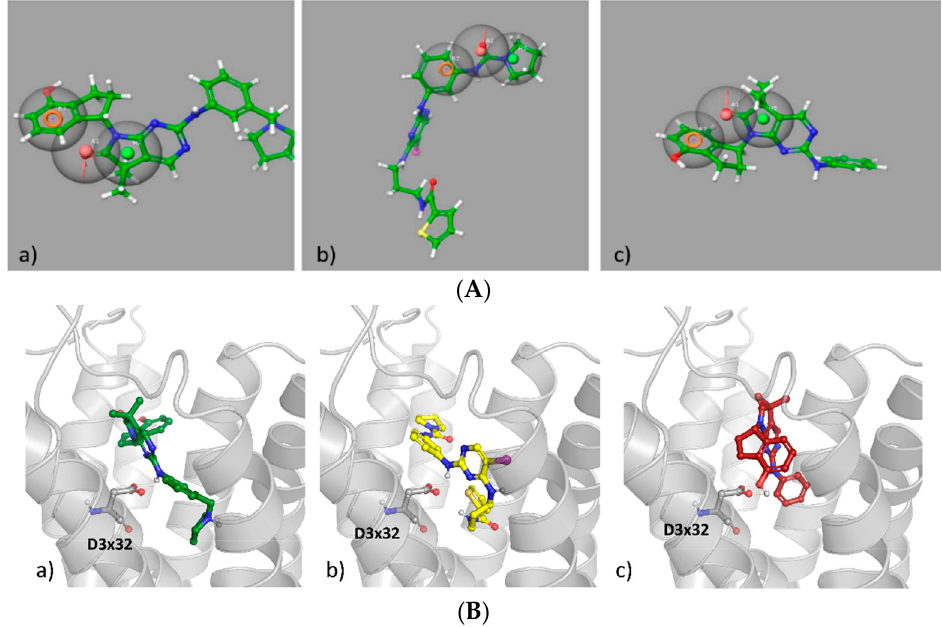
Figure 9. Examples of the most active MARK4 inhibitors: ( A ) mapped on the 5-HT 6 R pharmacophore model; ( B ) docked to the homology model of 5-HT 6 R; ( a ) 23, ( b ) 24, ( c ) 25